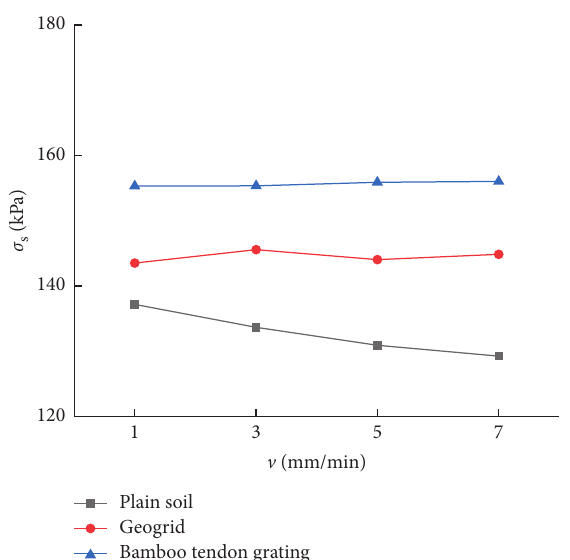
Figure 16: Shear strength of the soil interface under different shear rates for different reinforced materials.